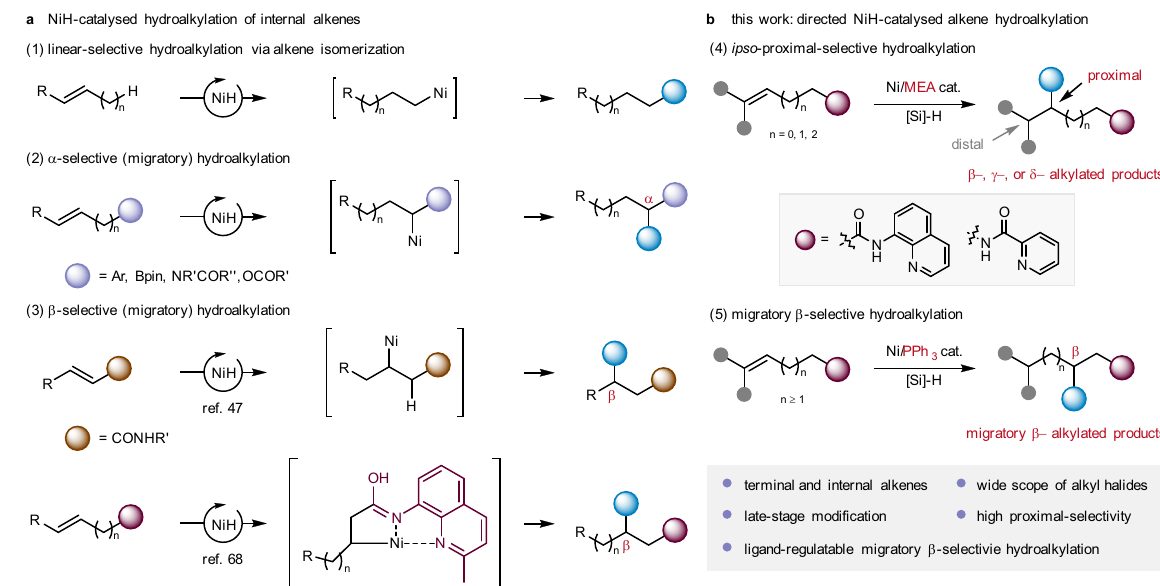
Fig. 1 NiH-catalysed hydroalkylation of internal alkenes and their regioselectivities. a NiH-catalysed linear-, α - or β -selective (migratory) hydroalkylation of internal alkenes. b Our strategy: directed NiH-catalysed proximal-selective hydroalkylation and migratory β -selective hydroalkylation. Bpin pinacol borate, diglyme 2-methoxyethyl ether, MEA